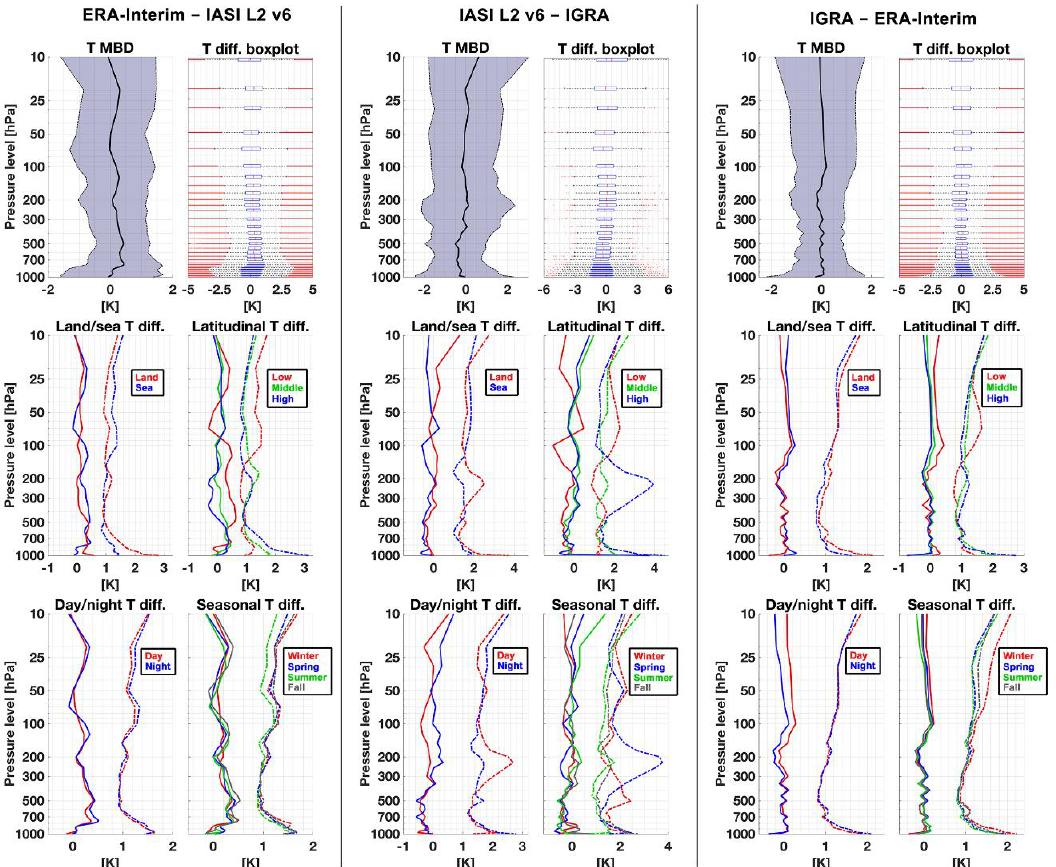
Figure A2. ERA-Interim, IASI L2 v6, and IGRA T intercomparisons. Top panels show mean bias difference (MBD) (solid) with standard deviations (dashed area) and the boxplot of the differences. Middle and bottom panels show MBD (solid lines) and root mean square difference (RMSD) (dashed lines) of the differences for land/sea surface, high/middle/low latitude, daytime/nighttime, and for the four seasons. ERA-Interim–IASI L2 v6, IASI L2 v6–IGRA, and IGRA–ERA-Interim are shown by the left, center, and right panels, respectively.